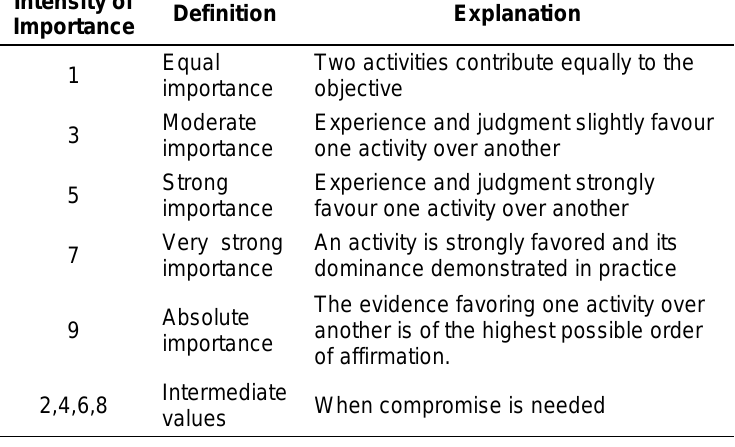
Intensity of Definition Importance